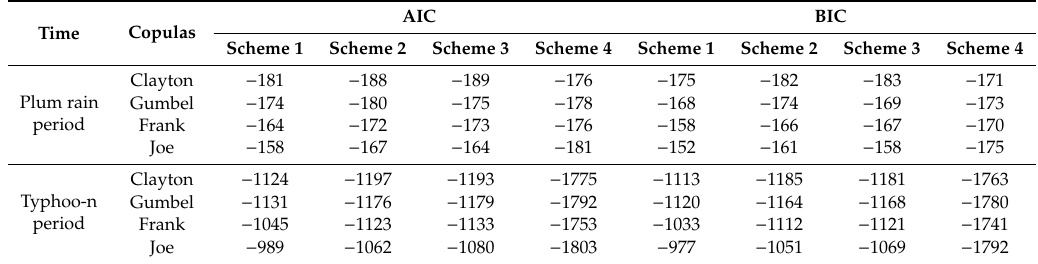
Table 6. Goodness-of-fit tests for the copula functions in the plum rain and typhoon